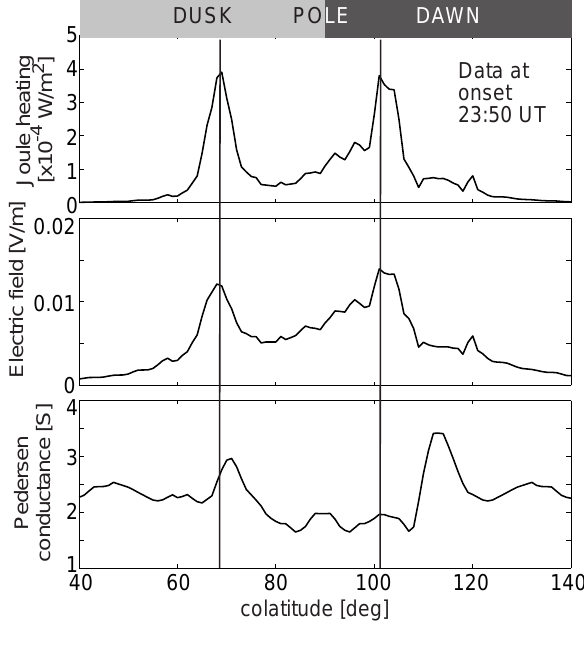
Fig. 10. GUMICS-4 Joule heating, electric field and Pedersen con- ductance along the terminator at 23:50